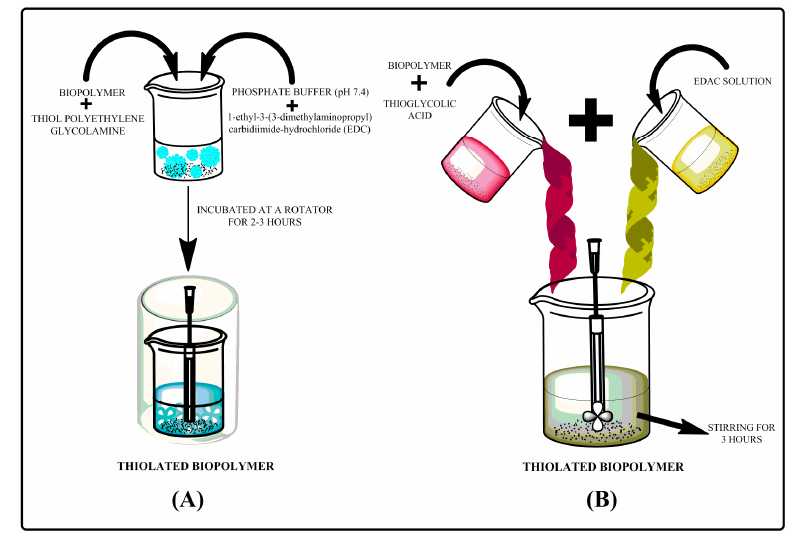
Figure 3. Step wise process of thiolation ( A ) by thiol polyethylene glycolamine and( B ) by thioglycolic